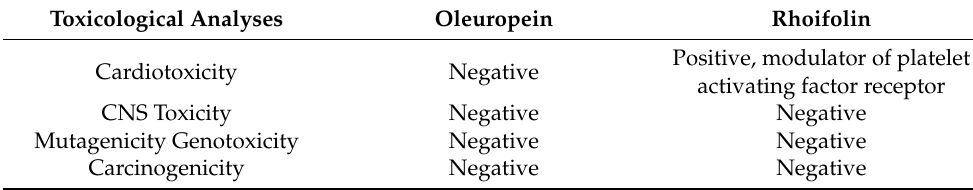
Table 5. Toxicological analyses of Oleuropein and